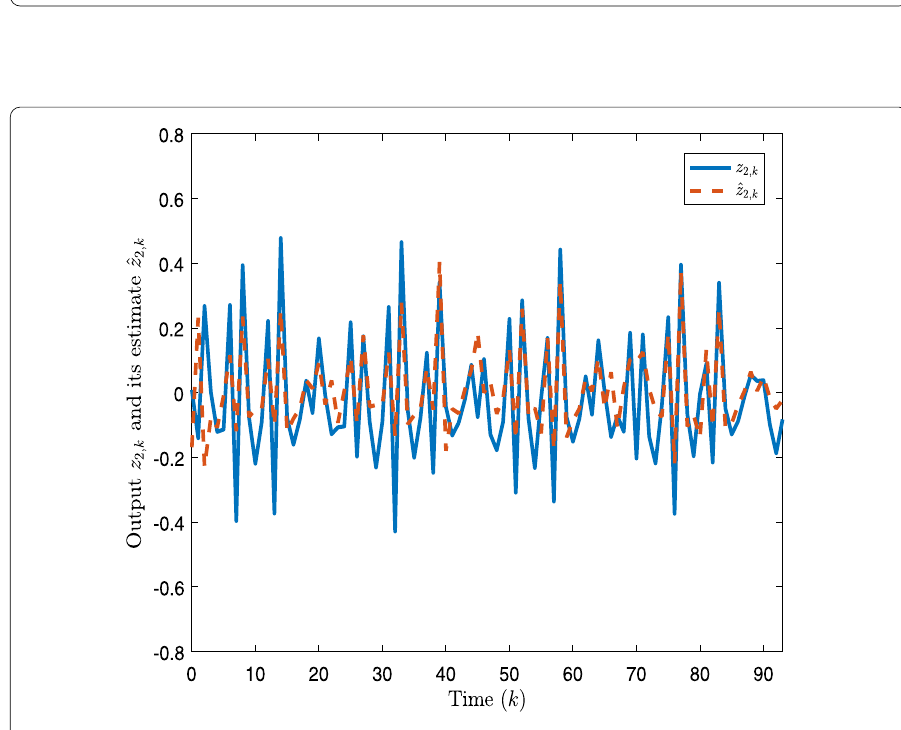
Figure 2 The controlled output z 2, k and its estimation